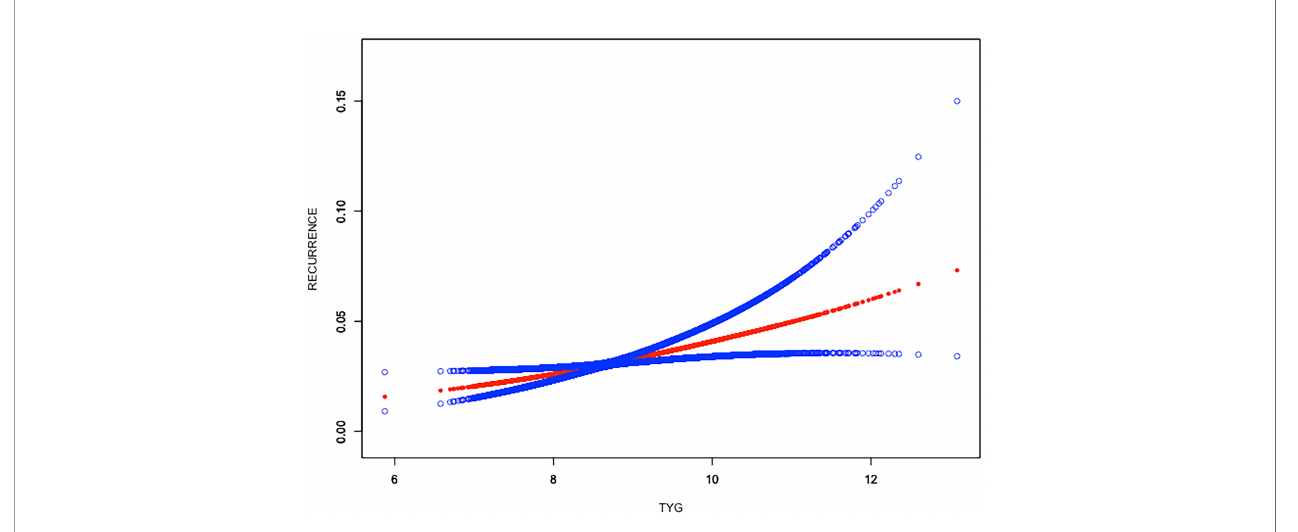
FIGURE 3 | Linear relationship between triglyceride – glucose (TyG) index and the recurrence of kidney stones by the generalized additive model.